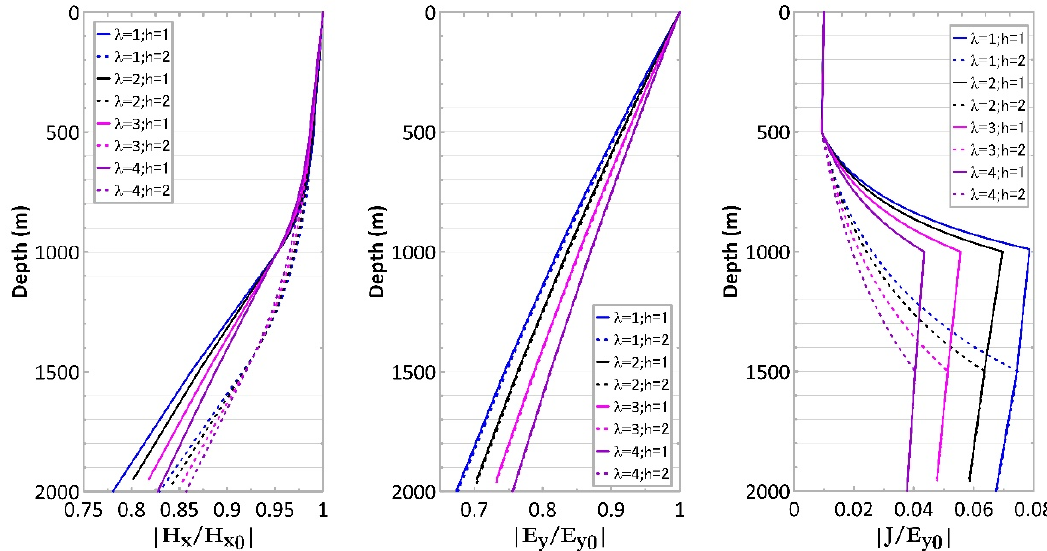
Figure 5. The variation in the amplitude of the normalized magnetic field (left panel), electric field (middle panel) and current density (right panel) with depths ranging from 0 to 2000 m for the anisotropic model with a dip angle of 15° in the bottom layer at a period of 10 s.